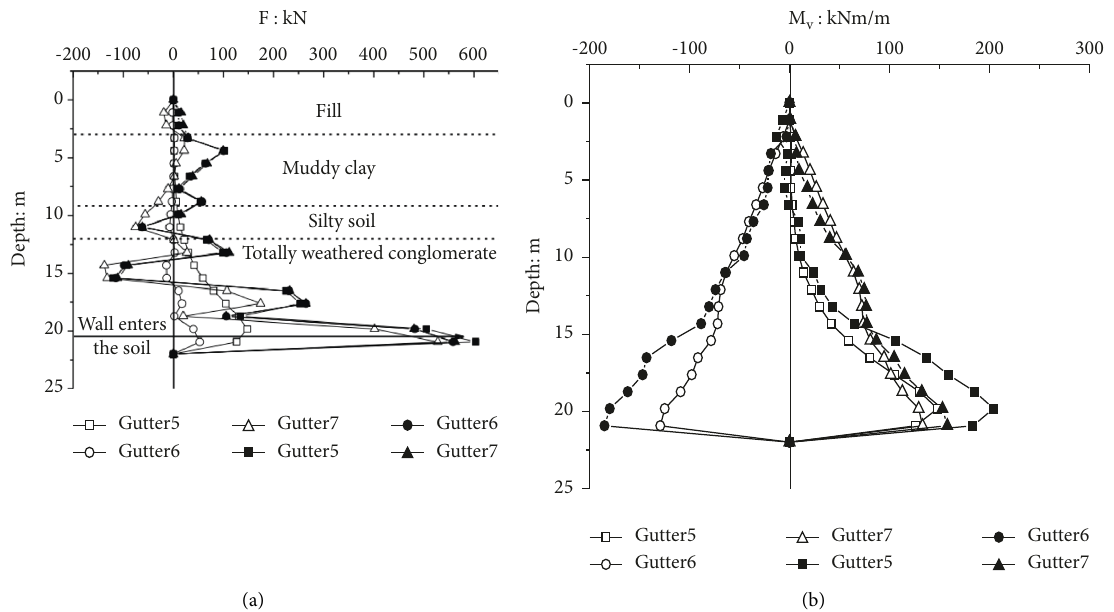
Figure 20: Vertical shear force and bending moment distribution with depth at Gutters 5, 6, and 7: effect of construction method. (a) Shear force. (b) Bending moment.